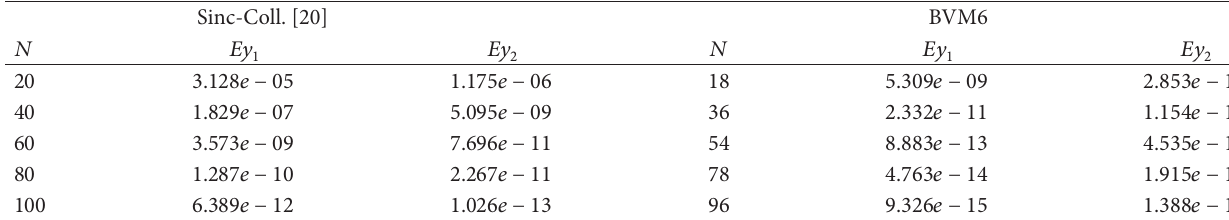
Table 1: Maximum errors for Example 1.